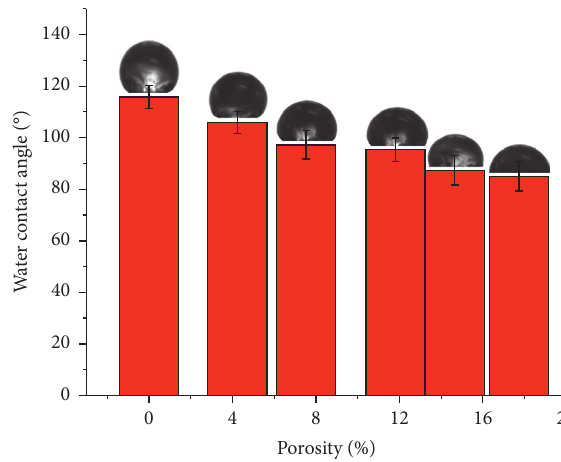
Figure 8: Water contact angle of modified fibers with different Table 1: Parameters of physical and mechanical performances of PA fibers with different porosities.